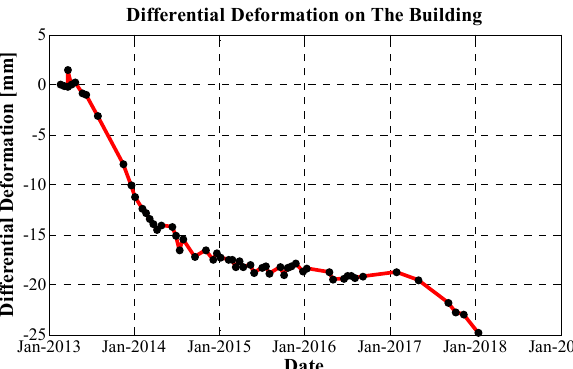
Figure 5. Settlement evolutions of the PS and their convergence points in the (a) north and (b) south parts of the building, respectively.